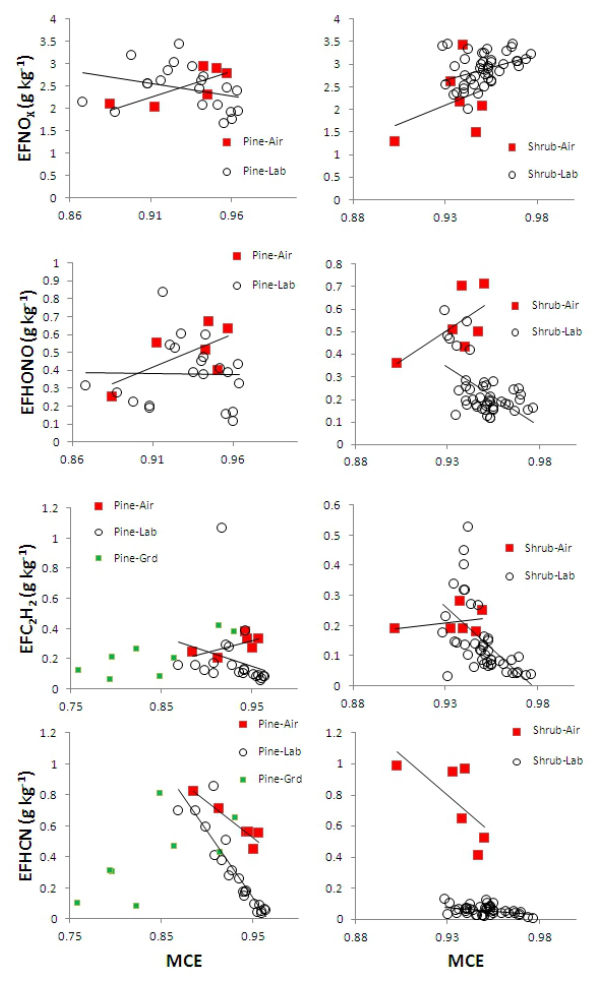
Fig. 3. Comparison of EF versus MCE from the lab and the field fires for flaming compounds and HCN for pine understory (left col- umn) and semiarid shrubland (right